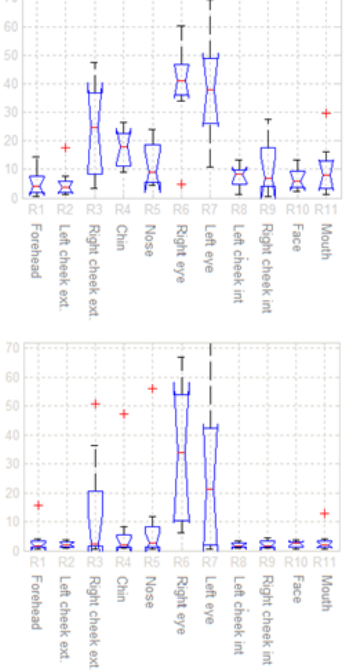
Figure 12. Box plots of heart rate median errors together with the 25th and 75th percentiles, for each face